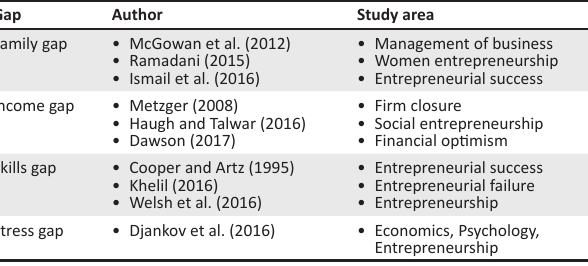
TABLE 2: Identification of gaps.